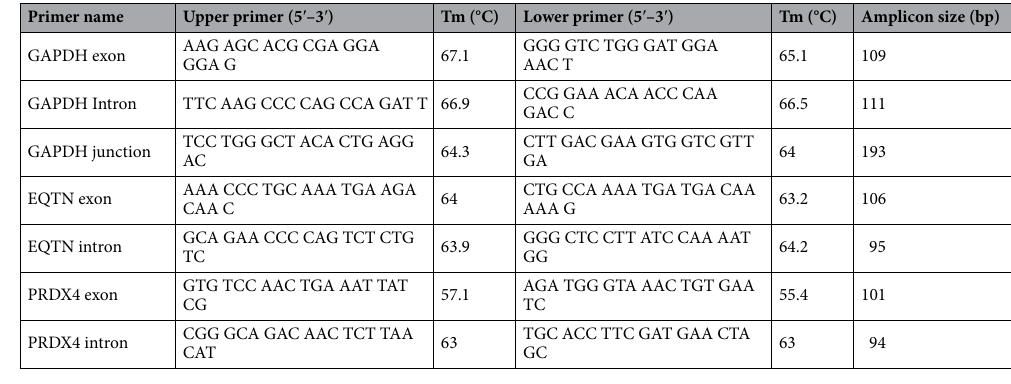
Table 2. Designed primers for RT-qPCR. All primers were designed genes from pig reference genome Sscrofa11.1 Primary Assembly. Gene accession number: GAPDH (ENSSSCG00000000694); EQTN (ENSSSCG00000005121); PRDX4